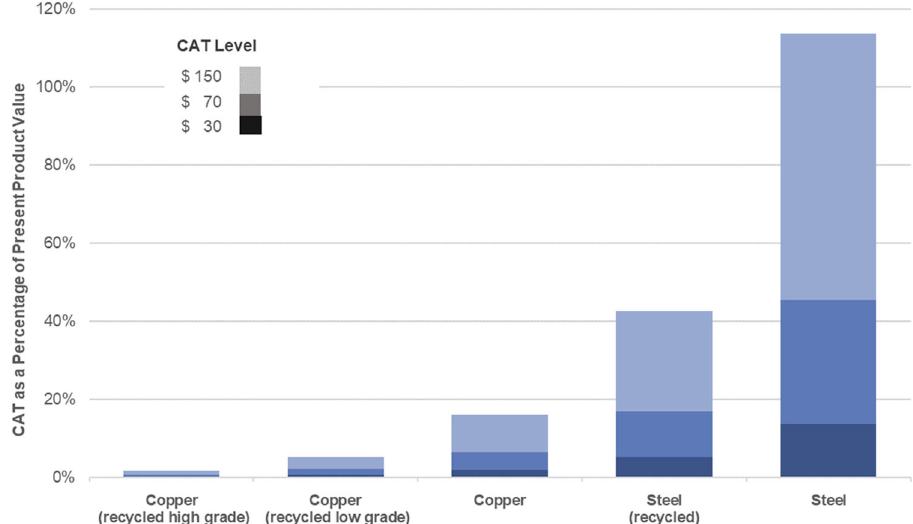
Fig. 5 Three levels of carbon taxation modeled as a percentage of present product value for selected primary and recycled copper and steel. The relative impact of a 30, 70, and 150 USD CAT on recycled and primary metal production on copper and steel. The increasing level of carbon added taxes are shown by increasingly lighter shades, 30 USD per tonne of carbon emitted is shown in the darkest color shade, whereas 150 USD per tonne of carbon emitted is shown in the lightest color